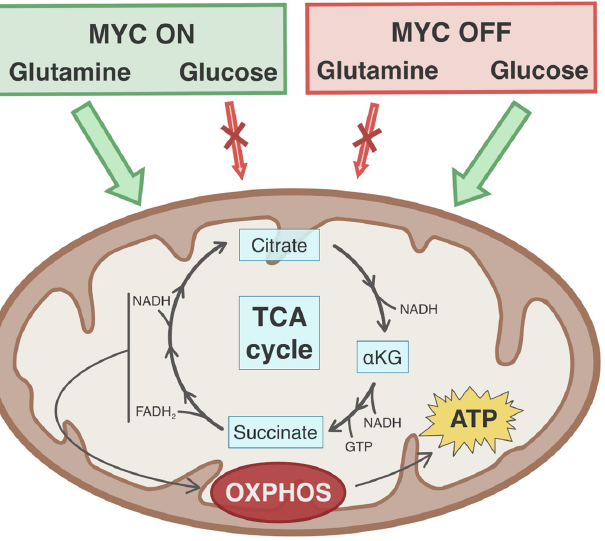
Figure 3. TCA cycle anaplerosis under the MYC oncogene. On the left (green box), activation of the MYC oncogene drives preferential metabolism of glutamine toward TCA cycle anaplerosis and subsequent oxidative phosphorylation. On the right (red box), loss of MYC oncogene expression increases dependency on glucose for mitochondrial metabolism.